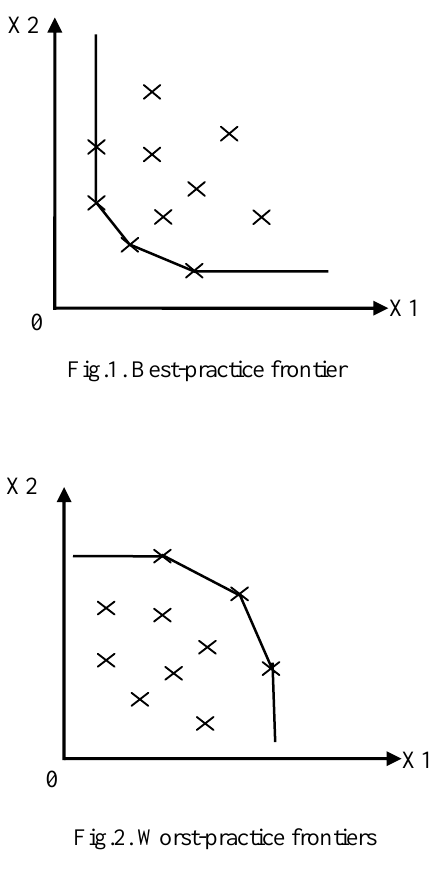
Fig.2. Worst-practice frontiers